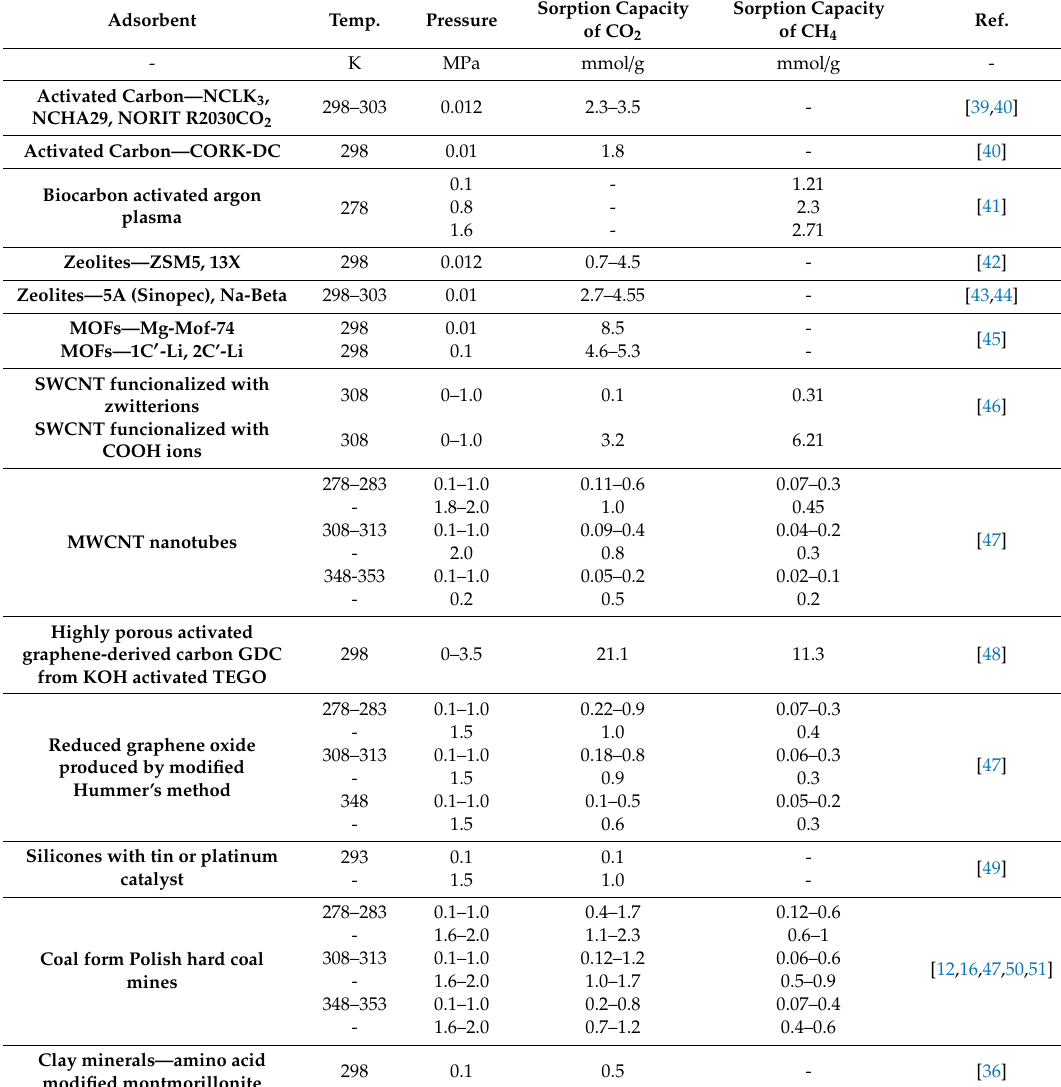
Table 1. Literature review concerning sorption capacity of synthetic and natural